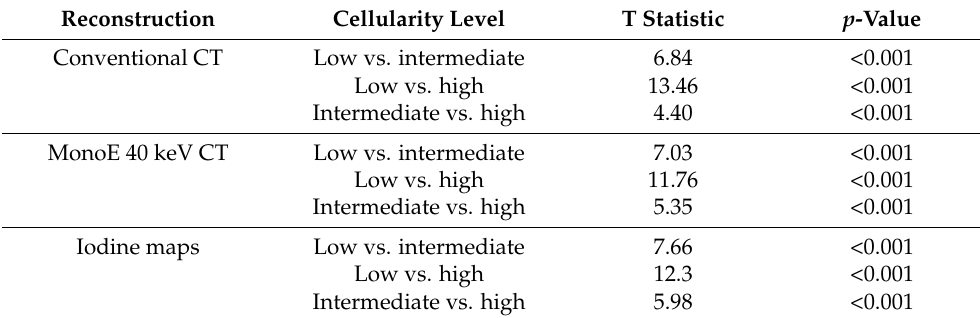
Table 4. Pairwise t -test for normalized values of low, intermediate and high cellularity level tumor regions for conventional, monoE 40 keV and iodine map reconstructions, respectively.